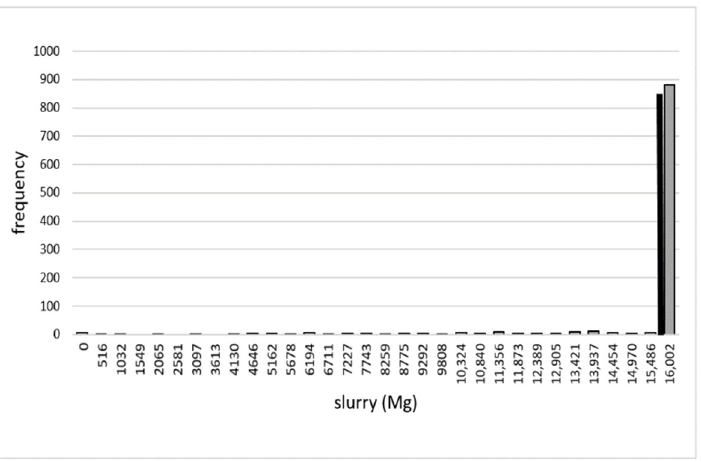
Figure A3. Histogram showing frequencies of achieving given quantity of sales slurry for mine “A” with σ yprog .